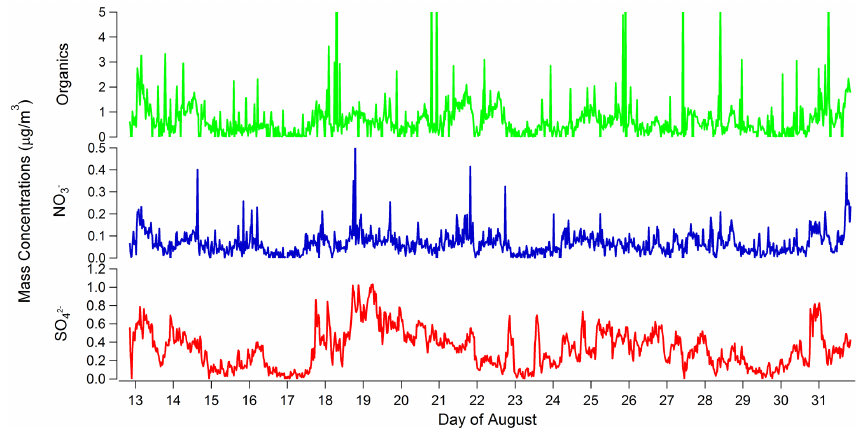
Figure 5. Time series (PDT) for 13–31 August of ACSM organics (green), NO − concentrations are 8µgm − 3 ; however, the axis only reaches 5µgm − 3 for